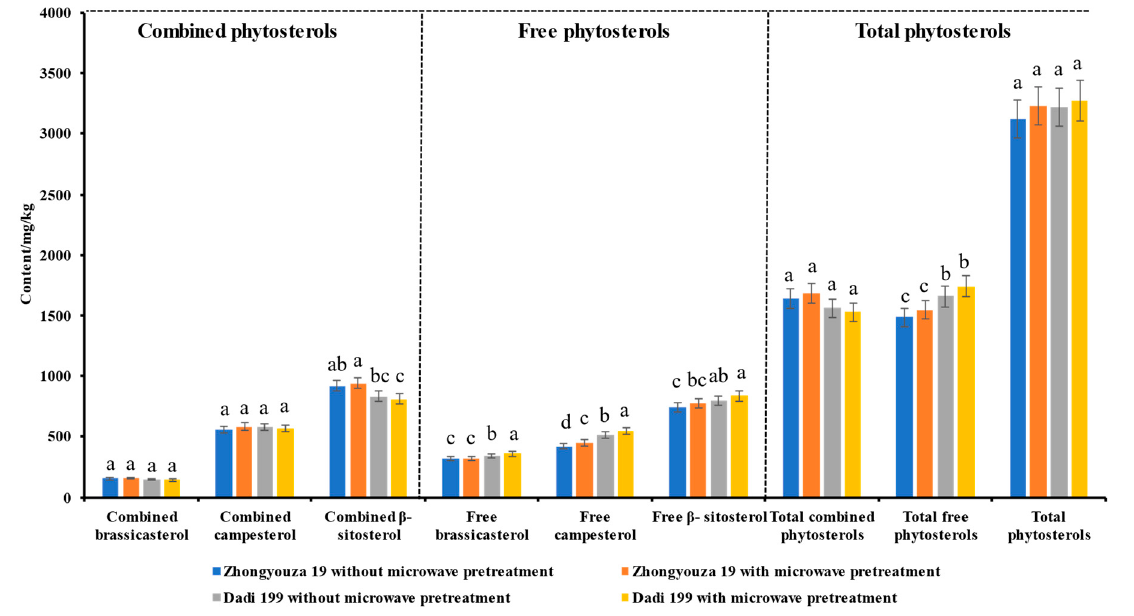
Figure 5. Effects of microwave pretreatment on the composition and content of phytosterols in rapeseed. Values are the means ± standard deviations; n = 3 parallel determinations. a–d Mean values (a > b > c > d, corresponding to the same parameter) not followed by a common letter differ significantly ( p <